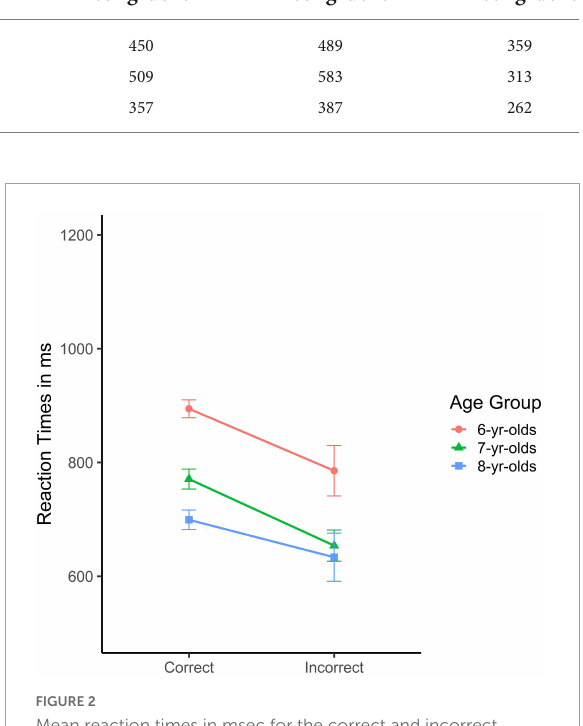
FIGURE2 Mean reaction times in msec for the correct and incorrect responses in the Flower block of the Heart and Flower task as a function of age group (error bars represent SEM) showing that participants in all three age group responded faster on incorrect compared to correct